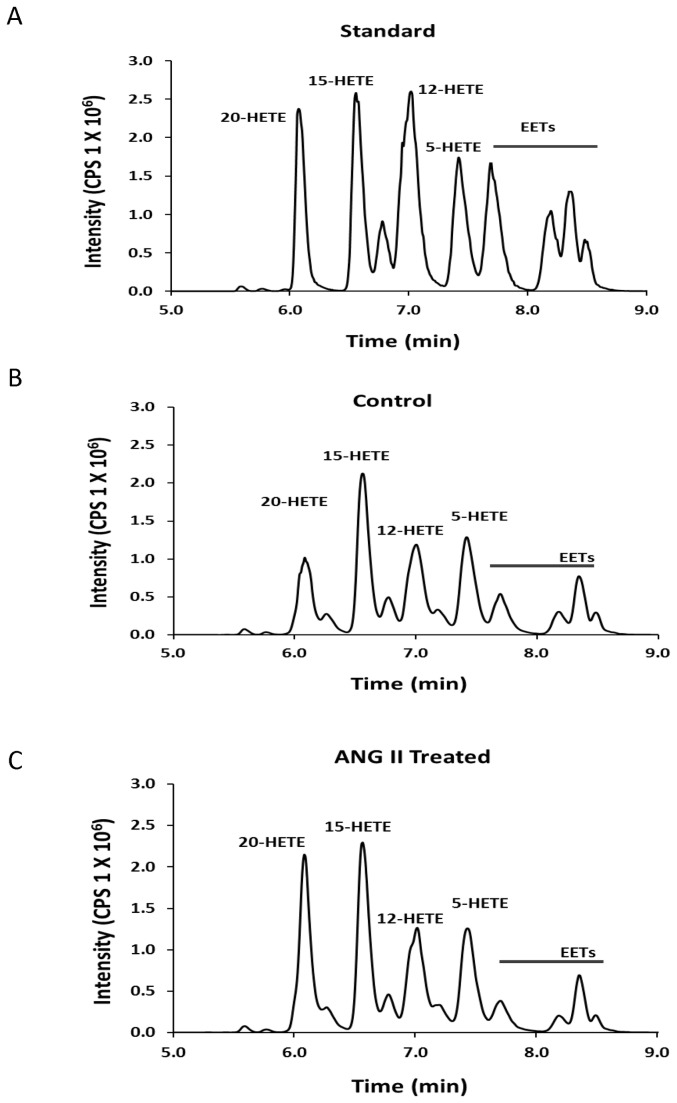
Production of 20-HETE in renal microvessels measured by LC/MS/MS.Panel A presents a typical chromatograph indicating the retention times of a mixture of 20 ng aliquots of various CYP450 metabolites of AA. Panel B presents a typical chromatograph of the metabolites of AA produced by control incubation of renal microvessels (0.68 mg protein). Panel C presents a typical chromatograph of the metabolites of AA produced when an aliquot of these same vessels were incubated with ANG II (0.66 mg protein).